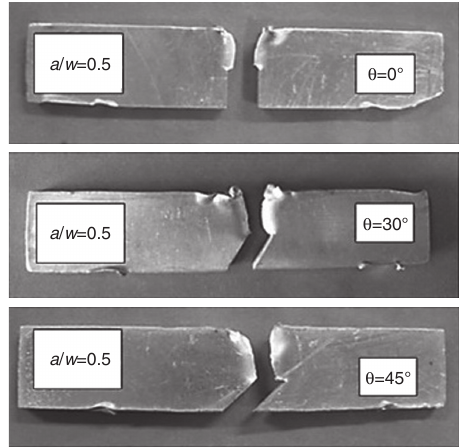
Figure 14 Experimental results of CPD.